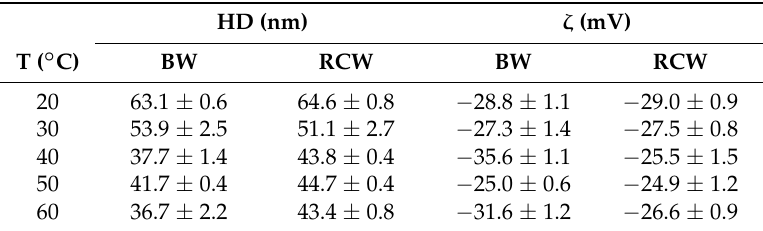
Table 2. Hydrodynamic diameter (HD) and zeta potential ( ζ ) of Ag-NPs obtained from bilberry waste (BW) and red currant waste (RCW) extracts at different temperatures (other conditions: pH = 11;